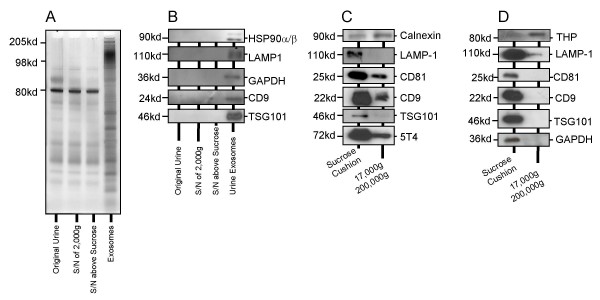
Purification of urine-derived exosomes. Healthy donor urine was subjected to exosome purification, and at each step, 10 μl of sample was kept for electrophoretic analysis (4–20% gradient polyacrylamide gel, silver stained) (A), demonstrating effective removal of the principal non-exosomal protein bands such as that at ~80 Kd, and significant enrichment of diverse protein species in the final exosome product (A). Parallel gels were run for immuno-blot analyses, using antibodies against typical exosome proteins as indicated (B). Comparing the sucrose cushion method, with a simpler method of Pisitkun et al, where cell culture media (C) or fresh urine (D) were subject to centrifugation at 17,000 g followed by pelletting at 200,000 g. Exosomes (from sucrose method) and the 200,000 g pellet were normalised for protein differences, and 2.5 μg/well analysed by western blot for markers as indicated.